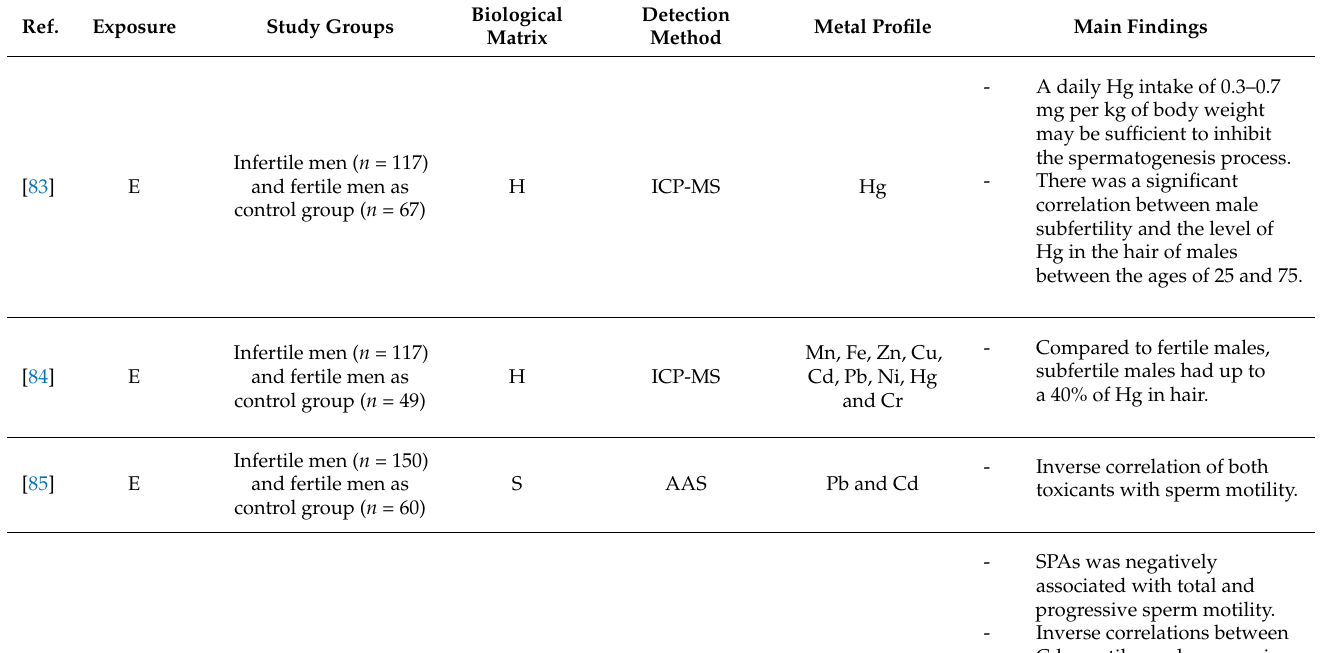
Table 4. Articles studying the relationship between heavy metals and reproductive parameters in occupationally or environmentally exposed study